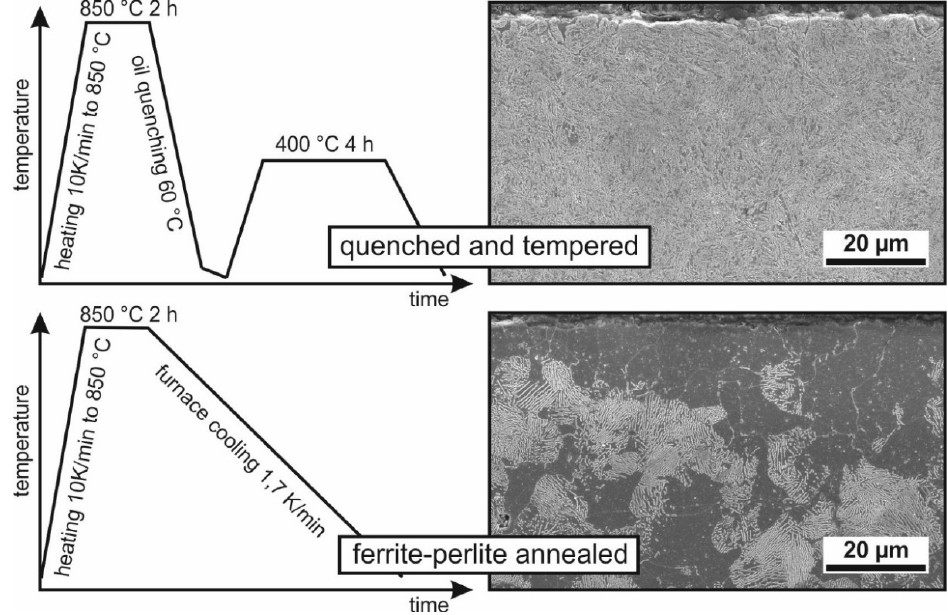
Figure 1. Heat treatment parameters and SEM-micrographs of the microstructure.